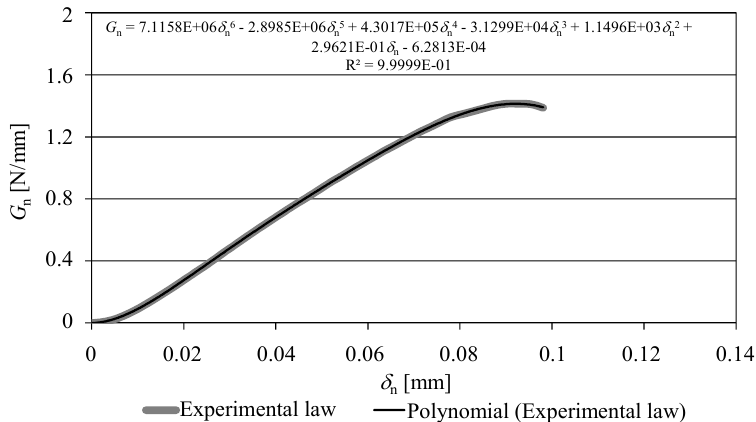
Figure 7: Experimental G n -  n law for one test specimen and polynomial fitting curve (configuration 1).